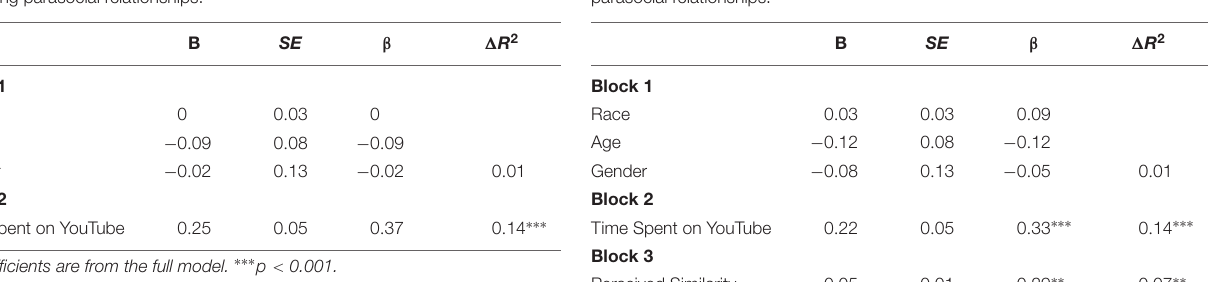
TABLE 6 | Summary of hierarchical regression for perceived similarity predicting parasocial